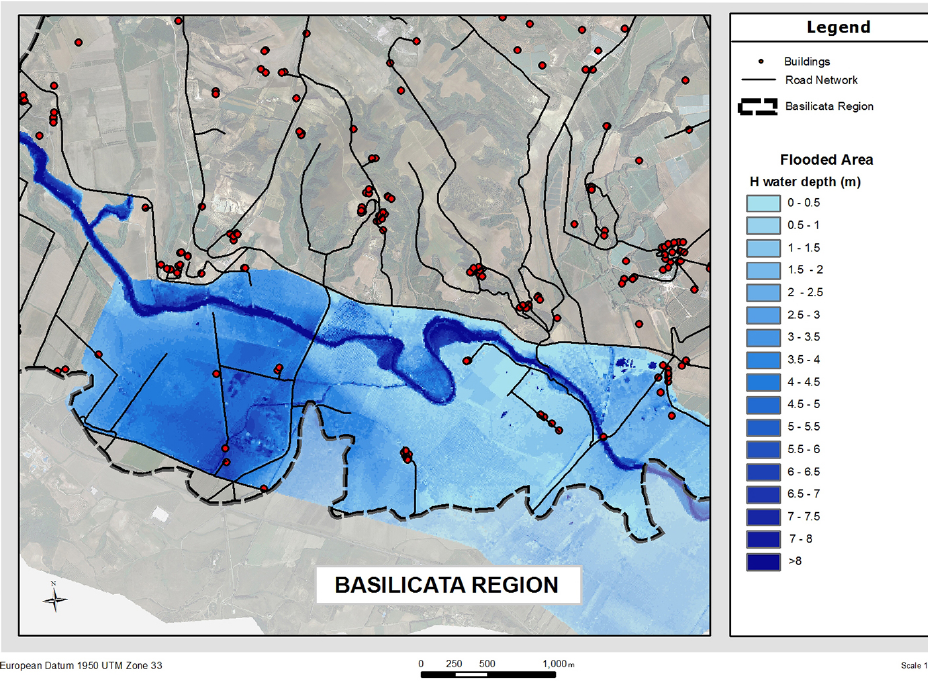
Figure 8. Water depth, H , from hydraulic modelling (upflow).